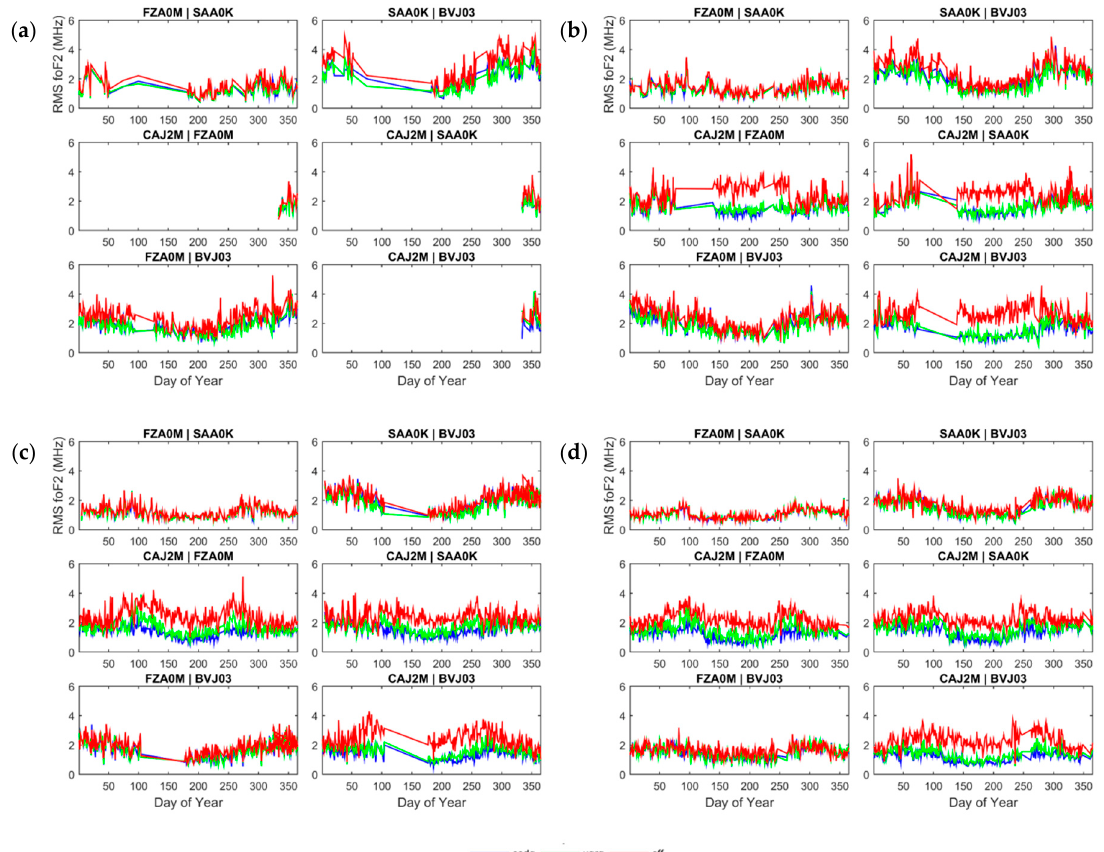
Figure 14. RMS values of the di ff erences between fo F 2 values estimated with two GIMs products (CODG and UQRG) and measured at the ionosondes for the six pairs of ionosondes for one-year data: ( a ) 2014; ( b ) 2015; ( c ) 2016; ( d ) 2017. Table 6. One-year mean RMS values of the di ff erences between fo F 2 values measured and estimated with GIMs (CODG and UQRG) and the simple di ff erence between the values of both ionosondes (o ff ). Ionosondes